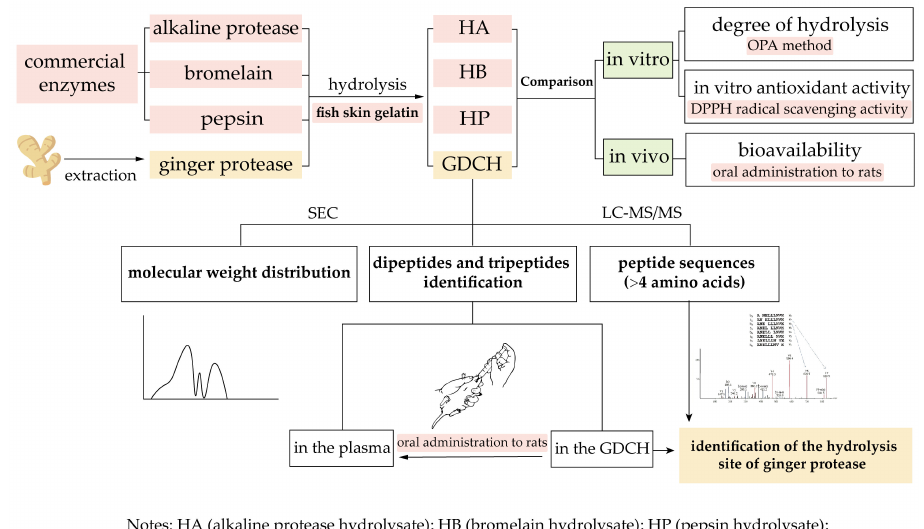
Figure 1. Flowchart of the study